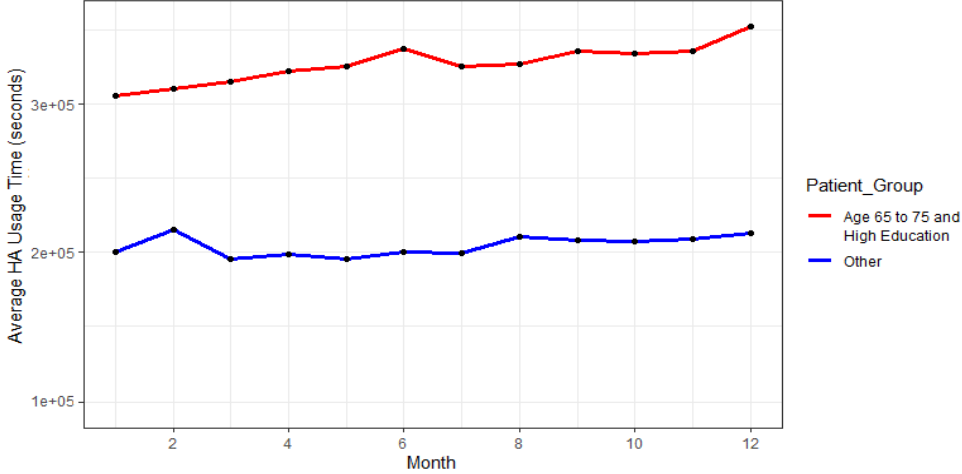
Figure 6. Comparison of average HA usage of the highly educated participants aged 65 to 75.